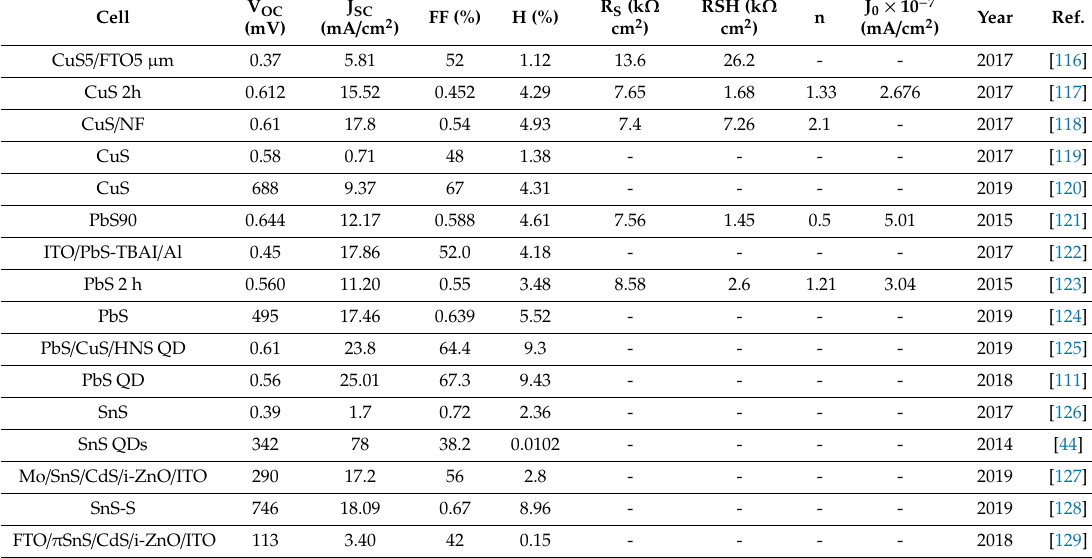
Table 2. Photovoltaic parameters of PbS, CuS and SnS solar